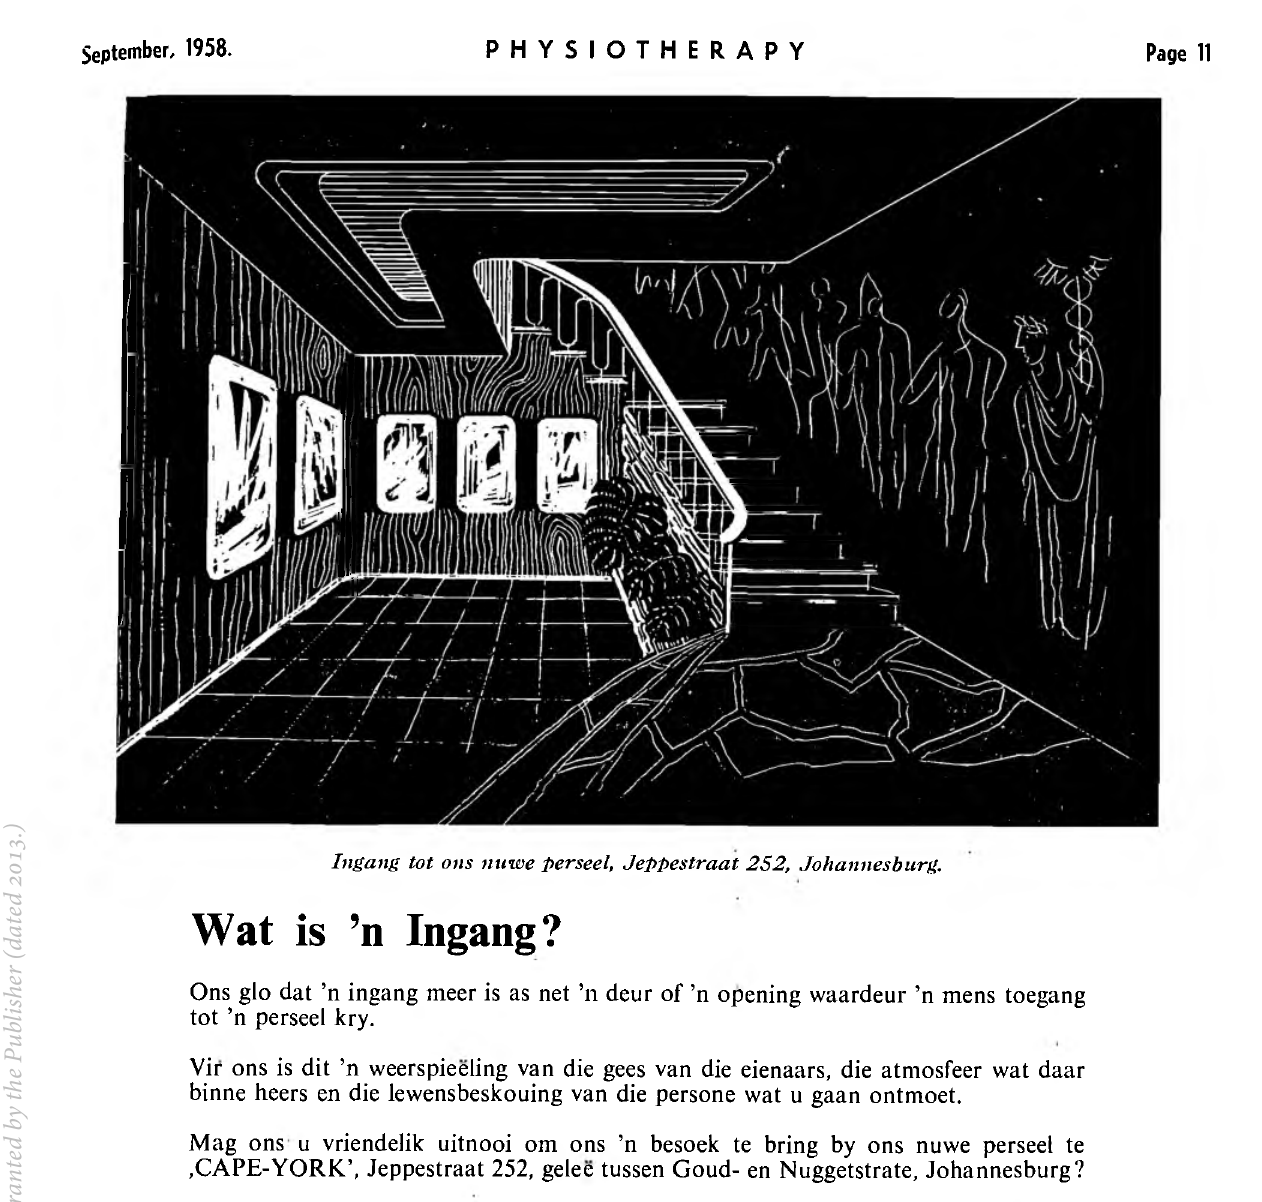
Vir ons is dit ’n weerspieeling van die gees van die eienaars, die atmosfeer wat daar binne heers en die lewensbeskouing van die persone wat u gaan ontmoet. Mag ons u vriendelik uitnooi om ons ’n besoek te bring by ons nuwe perseel te ,CAPE-YORK’, Jeppestraat 252, gelee tussen Goud- en Nuggetstrate, Johannesburg? Die ingang is in Jeppestraat, op die grondverdieping, derde winkel van die hoek van Goudstraat. Sodra die gebou voltooi is sal daar voldoende parkeerplek wees. Jn die tussentyd druk asseblief die .Parkeerknoppie’ in die ingangsportaal en u kar sal veilig versorg word terwyl u deur ons vertoonkamer